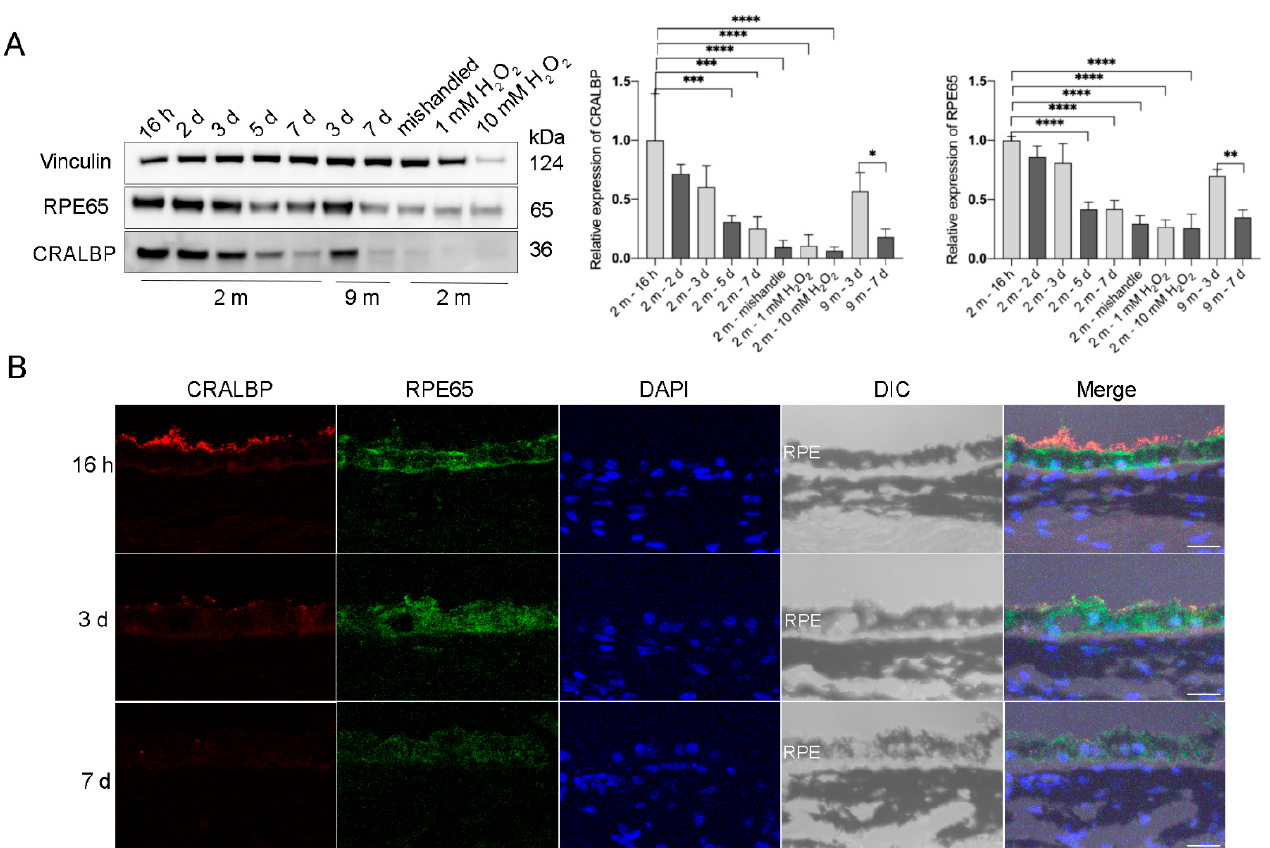
Figure 3. Visual cycle proteins were abundantly expressed in the RPE flatmounts during the first 3 days in culture, but gradually decreased over time. RPE flatmounts obtained from 2- and 9-month-old wild-type C57BL/6J mice were cultured in complete medium for up to 7 days. RPE flatmounts treated with H 2 O 2 were cultured for 16 h. ( A ) Protein lysates were prepared from the RPE flatmounts and subjected to western blotting analysis to detect the levels of visual cycle proteins RPE65 and CRALBP. Statistical analysis was performed using one-way ANOVA. * p < 0.05, ** p < 0.01, *** p < 0.001, **** p < 0.0001. n = 3. ( B ) RPE65 and CRALBP protein levels were also measured by immunofluorescence. Data from both the western blotting and immunofluorescence showed the gradual reduction in the two proteins in RPE flatmounts over time. Scale bar = 20 μ m.